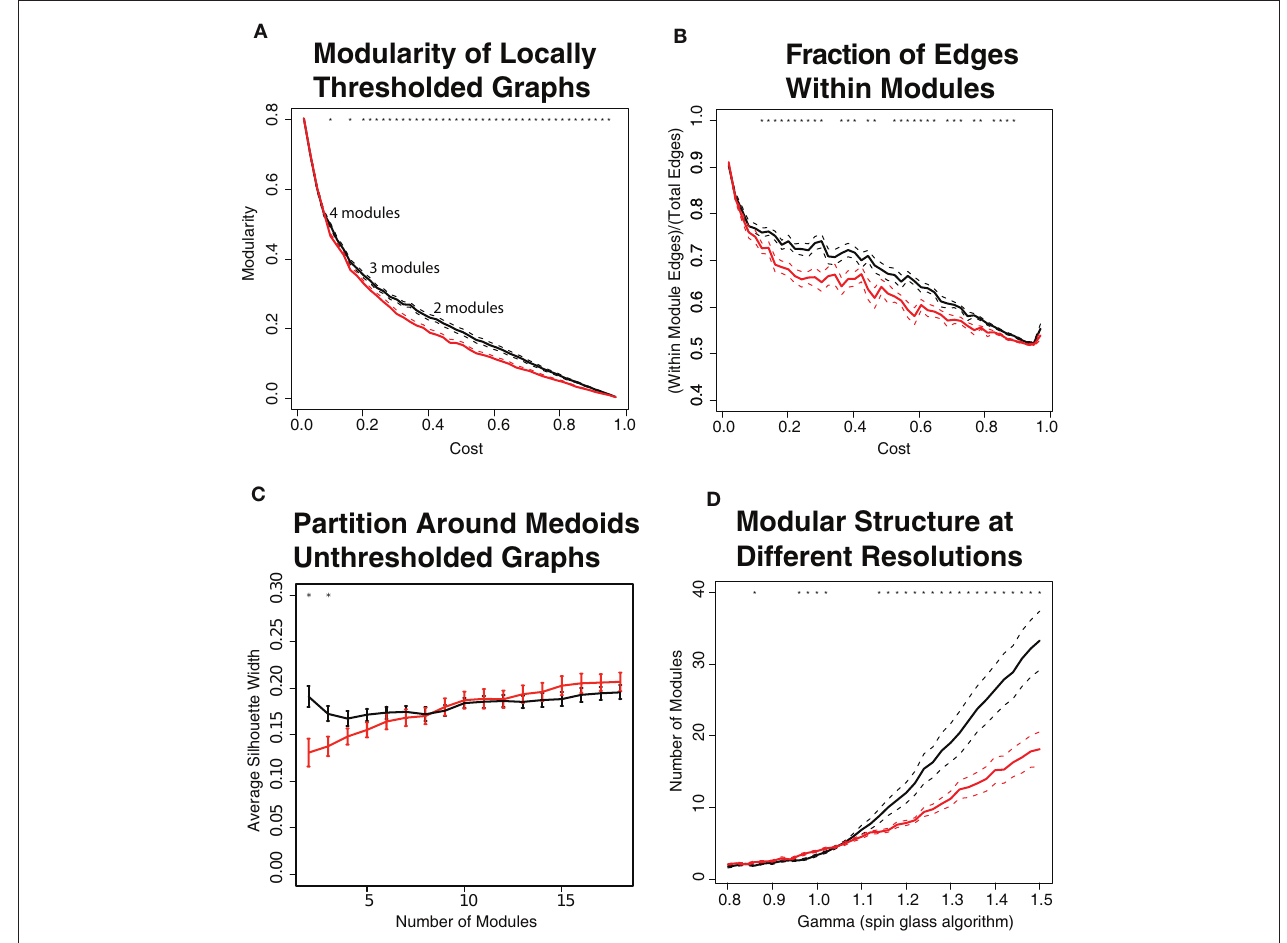
FIguRe 6 | The modular structure of brain networks is disturbed in the childhood-onset schizophrenia (COS) population (red) relative to the control population (black). (A) Modularity is calculated using the fast greedy algorithm on binary, locally thresholded graphs. The COS networks have lower modularity, especially in the range of topological costs where the networks are partitioned into less than 5 modules. (B) The fraction of intra-modular edges, which link nodes in the same module, is decreased in COS. This value is the same as modularity